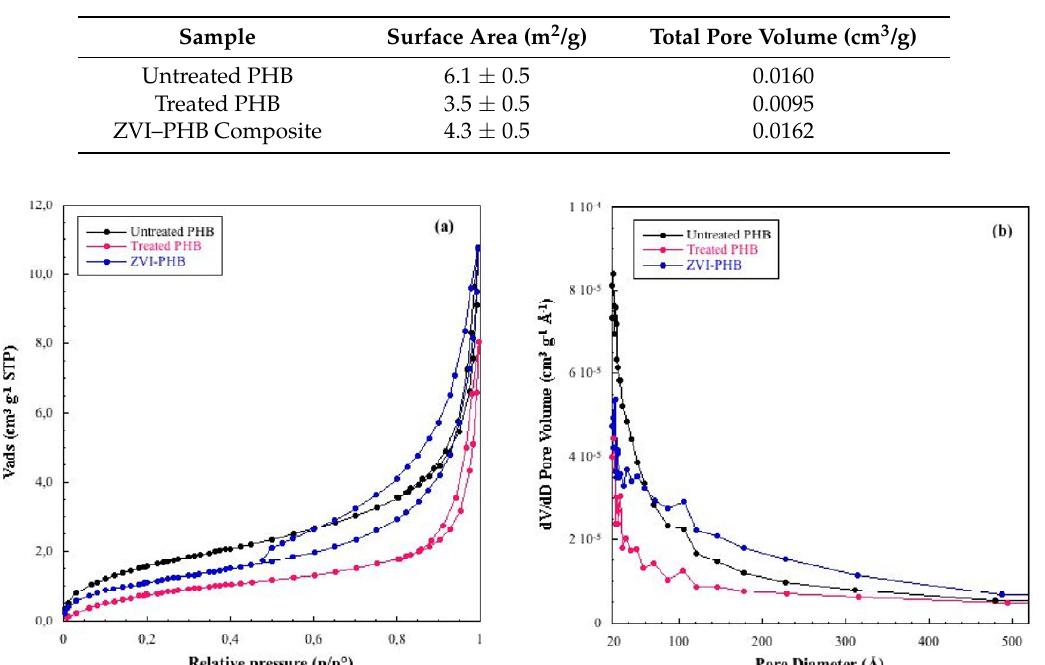
Figure 3. ( a ) N 2 adsorption/desorption isotherms; and ( b ) pore size distribution of commercial untreated PHB, thermally treated PHB, and ZVI–PHB composite samples (ZVI/PHB ratio 1:2 w / w ).